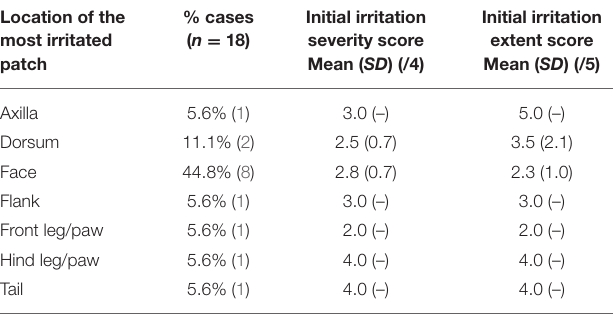
TABLE 2 | Location, extent, and severity of the most irritated patch at D0 ( n = 18). Location of the most irritated